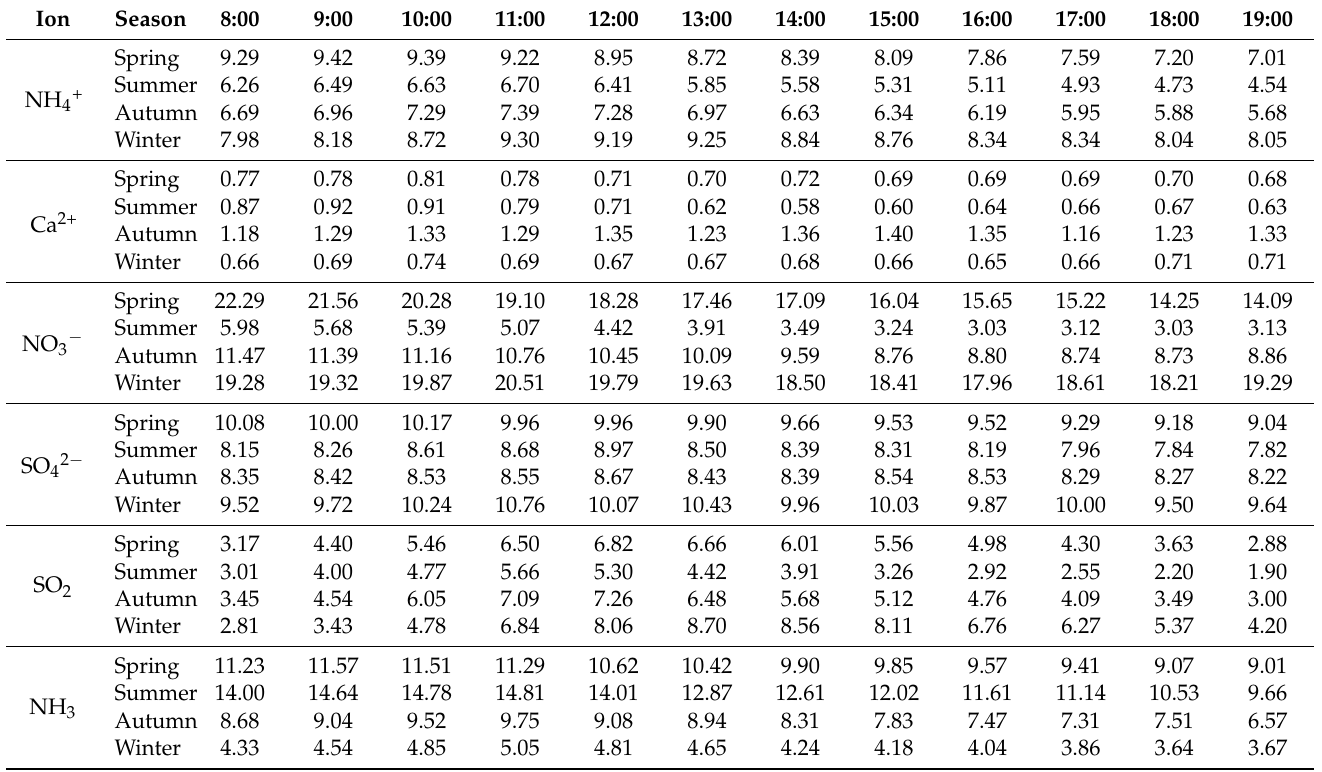
Table 1. Seasonal variation in diurnal concentrations of different ions ( µ g/m 3 ).